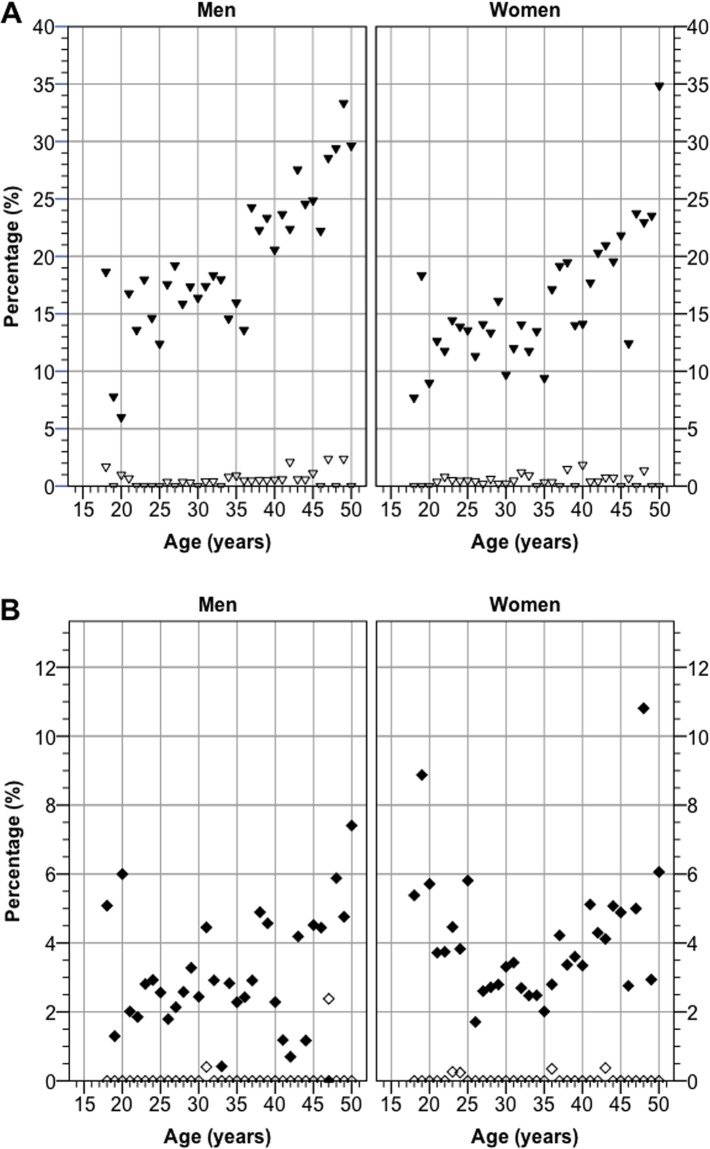
Prevalence of different self-assessed hearing problems versus age, stratified by sex.A, Percentage of subjects answering ”Slightly impaired” (closed triangles) or ”Very impaired” (open triangles) on the question ”How is your hearing?” (Q1). B, Percentage of subjects answering ”Sometimes a bit difficult” (closed squares) or ”Yes, very difficult” (open squares) on the question ”Is it difficult for you to hear when talking with one person in a quiet room?” (Q2). Missing answers and answers of ”Do not know/Do not want to answer” on Q2 were classified as absence of hearing difficulties.